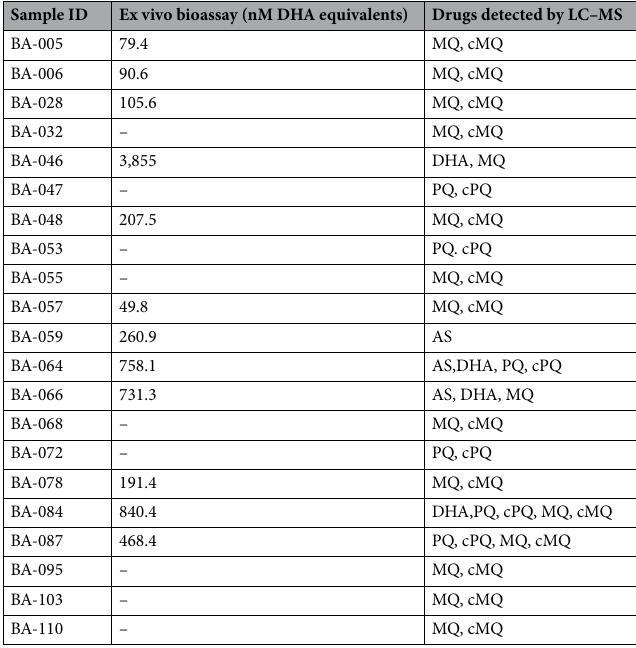
Table 4. Comparison of preexisting antimalarial activity in the samples obtained by ex vivo bioassay and liquid chromatography-mass spectrometry